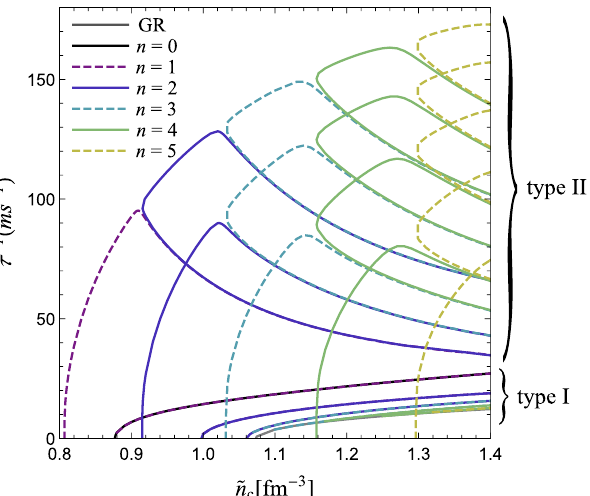
Figure 5. Inverse of the instability timescale of unstable modes as a function of the central density of the corresponding equilibrium solution, for the regularized variant of the symmetron model, with M s / M Pl = 0.1. Color-coding is the same as in the right column of Figure 3, and refers to the number n of nodes in the associated equilibrium solution. Two types of unstable modes are found, corresponding to a fluid-driven (type I) or a scalar-driven (type II)